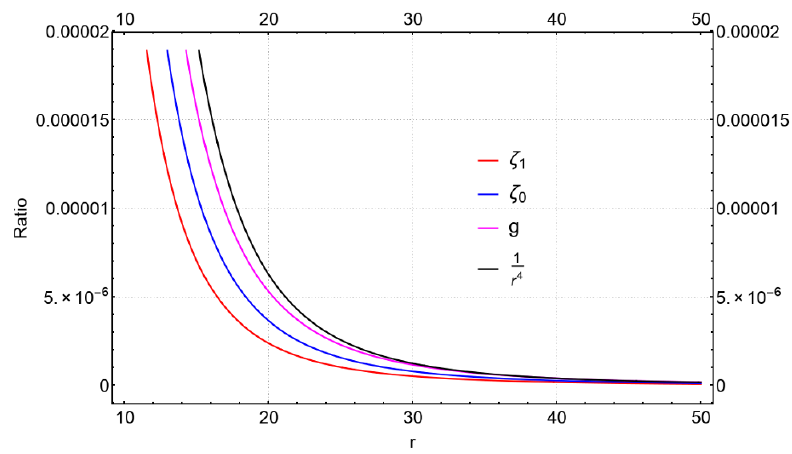
Figure 3 . Relative sewing precision for M = S 3 (cid:2) S 3